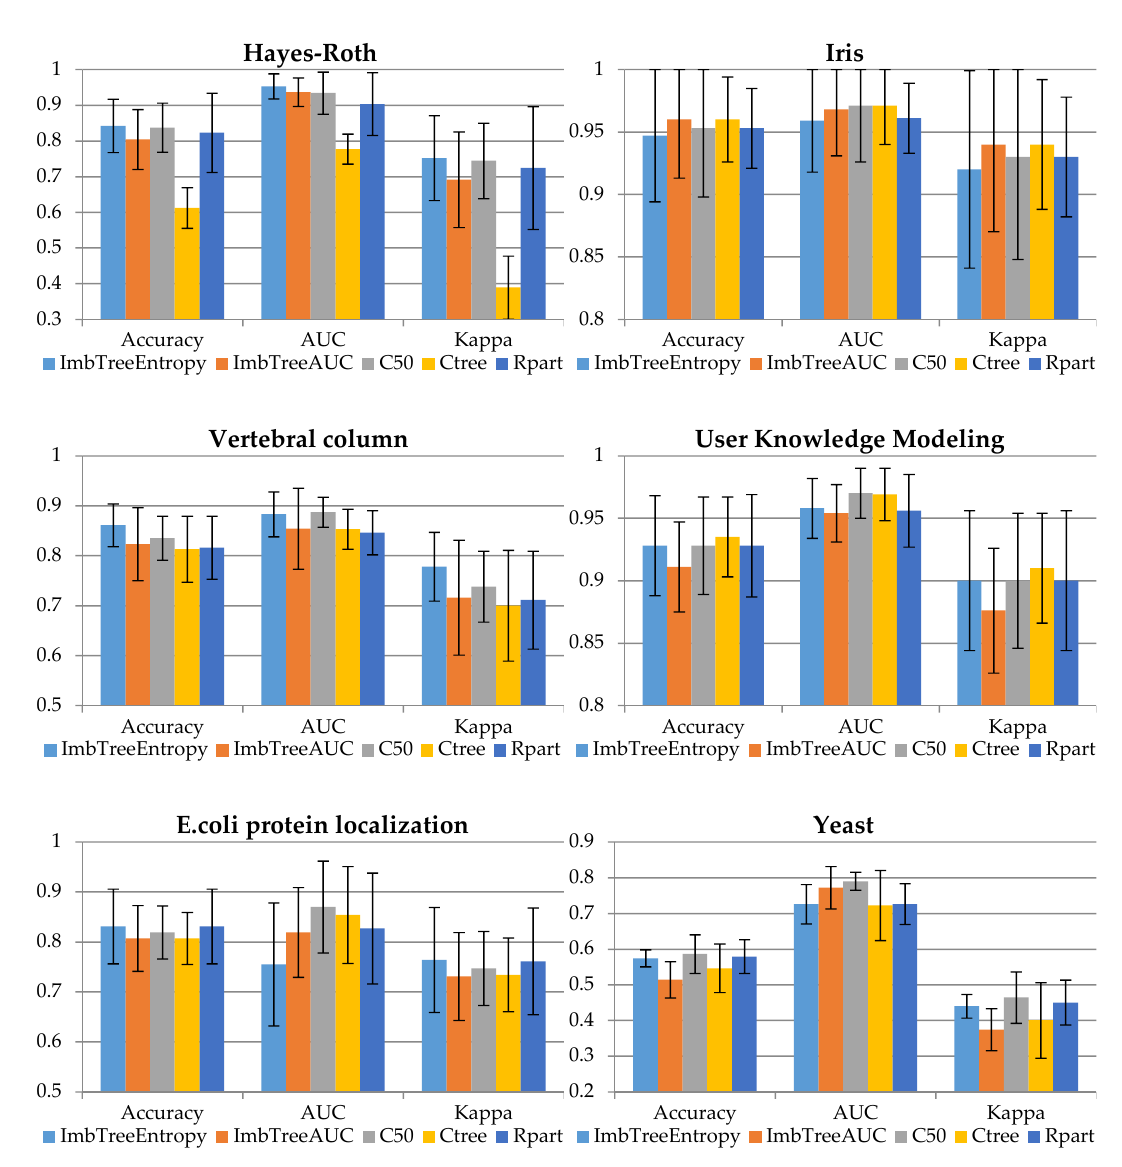
Figure 1. Comparison of classification accuracy results. Table 3. Comparison of tree structures in terms of number of leaves and predicted classes.